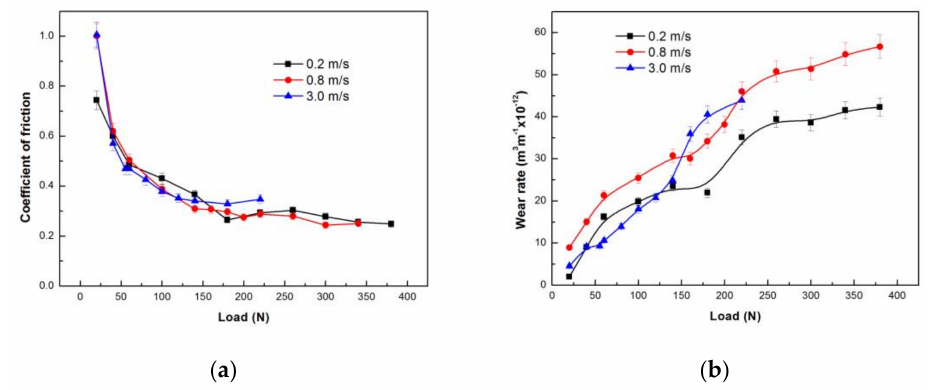
Figure 3. Coefficients of friction ( a ) and wear rates ( b ) as a function of applied load for tests conducted at different speeds of 0.2, 0.8 and 3